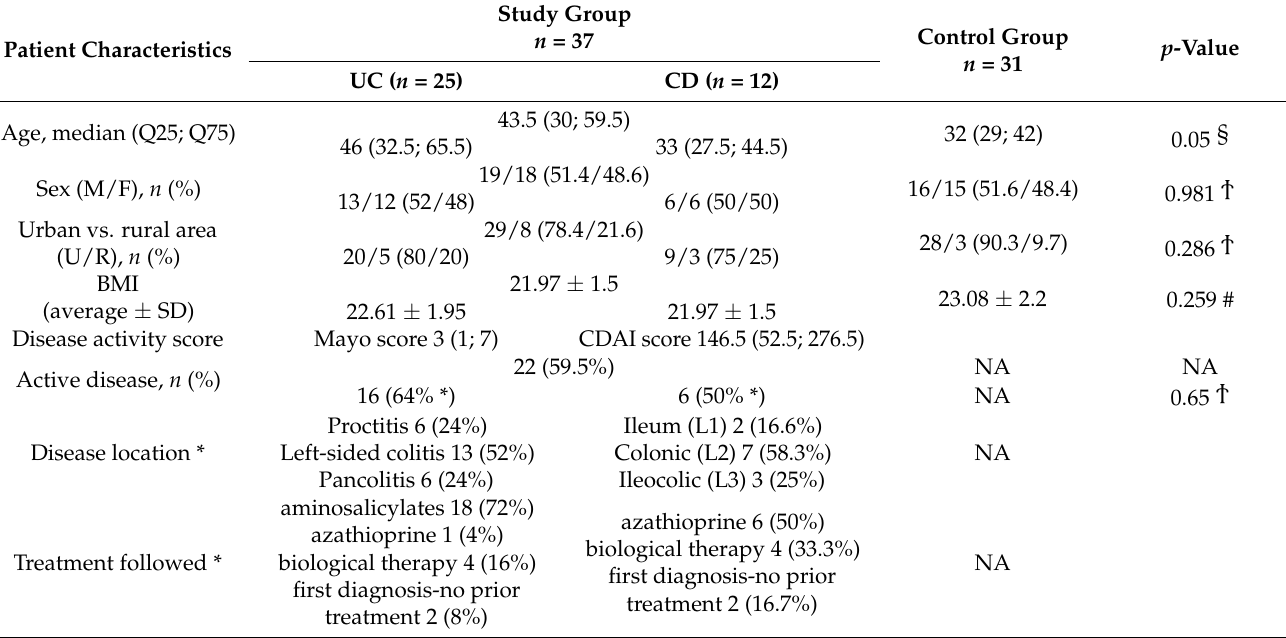
Table 1. Patient characteristics. Table 1. Patient